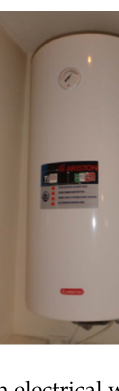
Figure 4. Example of an electrical water heater used for the shower.